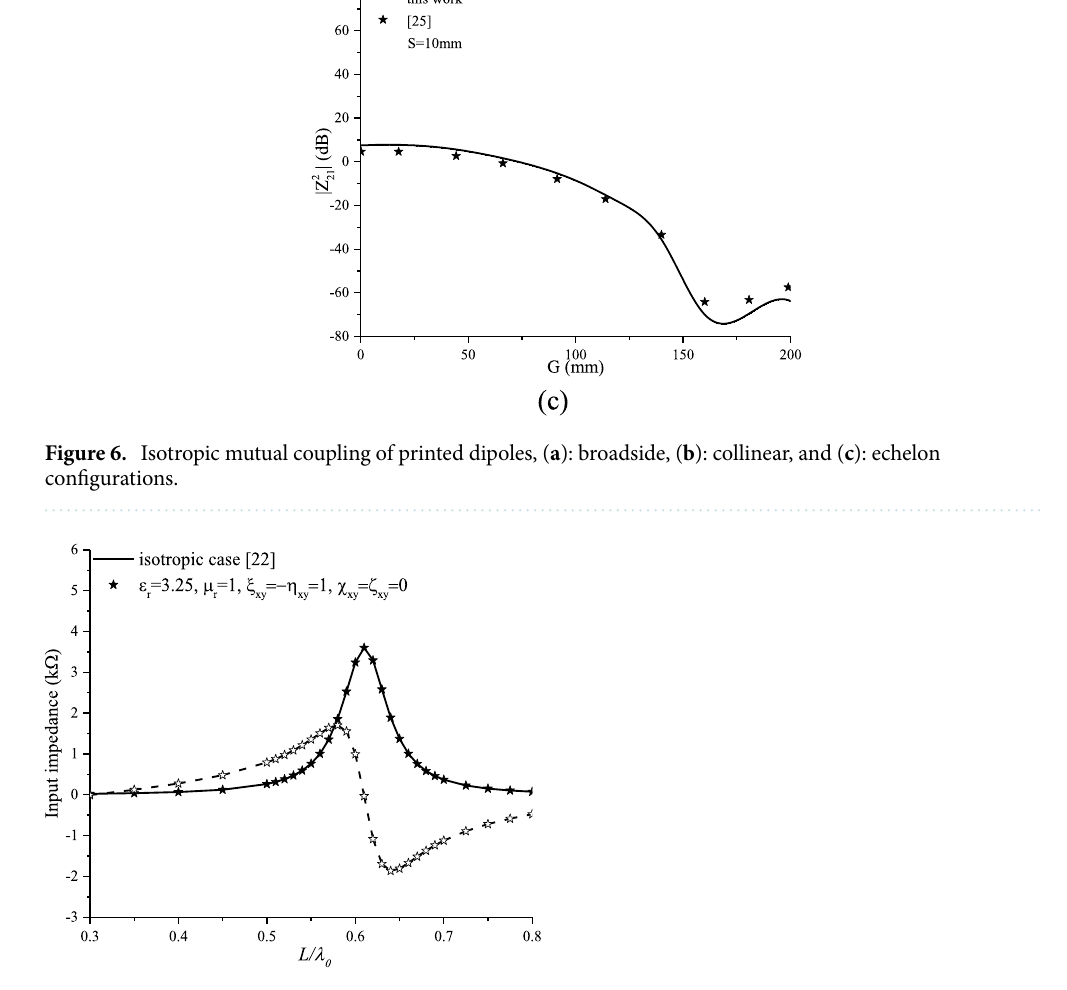
η xy ) on the input = −